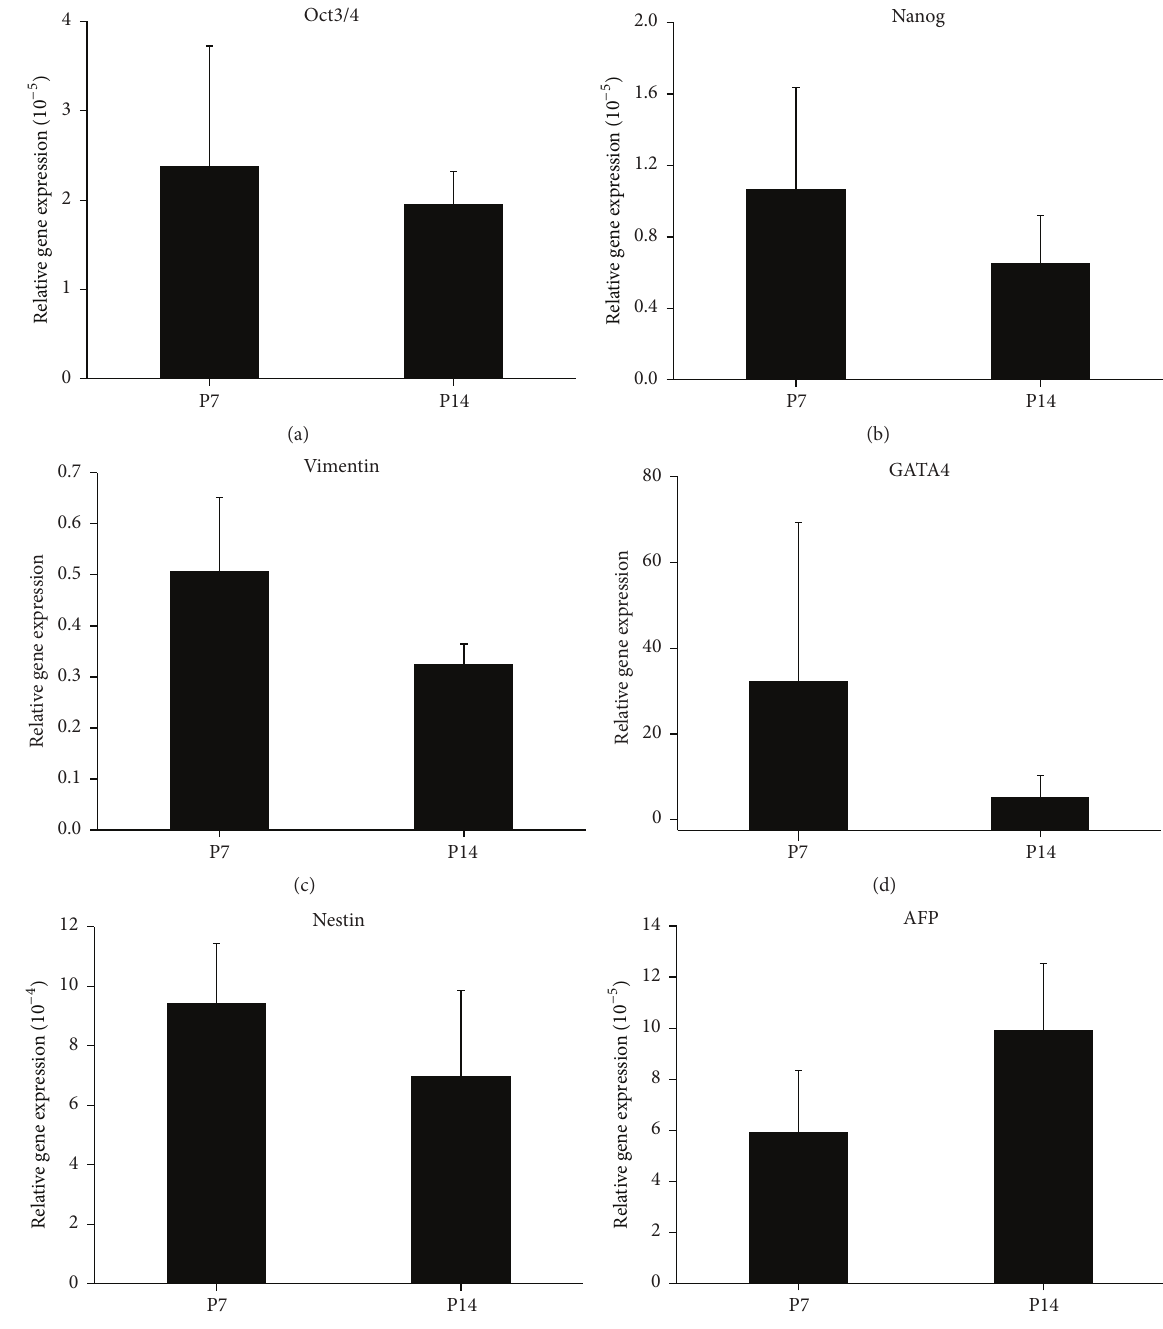
Figure 4: The expression of pluripotency genes and triploblastic progenitor marker genes in WJ MSCs (Wharton’s jelly-derived mesenchymal stem cells) in the early and middle phases. (a–c) There was a downward trend in the expression of Oct3/4, Nanog, and Vimentin in the middle phase compared to the early phase. (d–f) The expression of GATA4, Nestin, and AFP in the early and middle